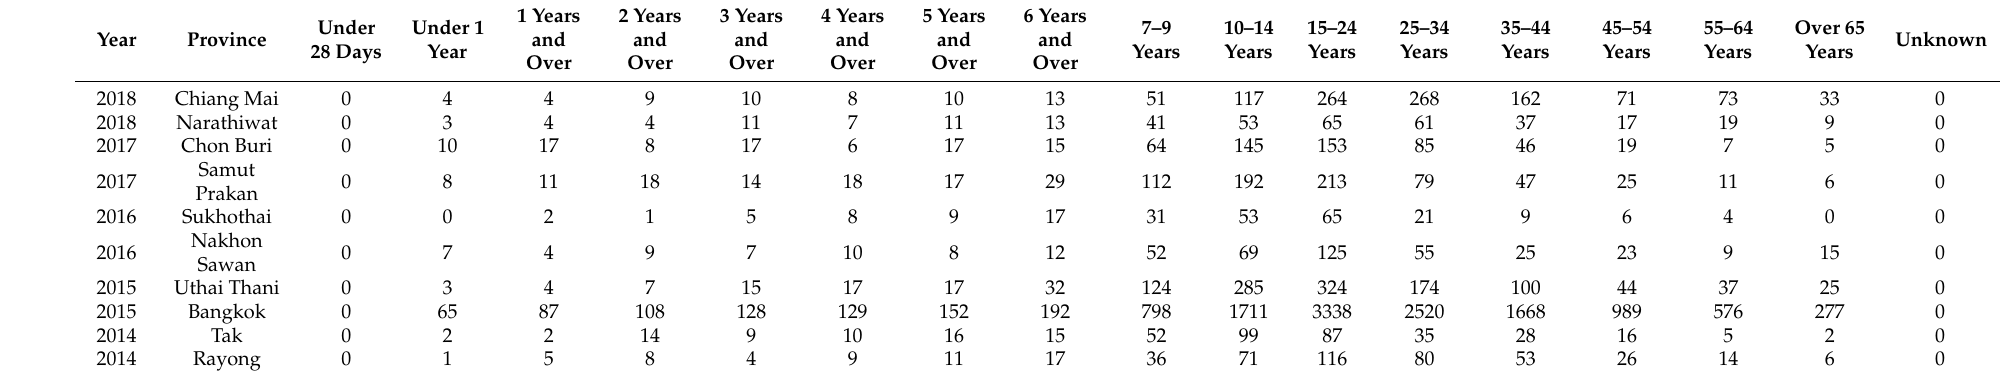
Table 1. Age category report from the dengue fever dataset.